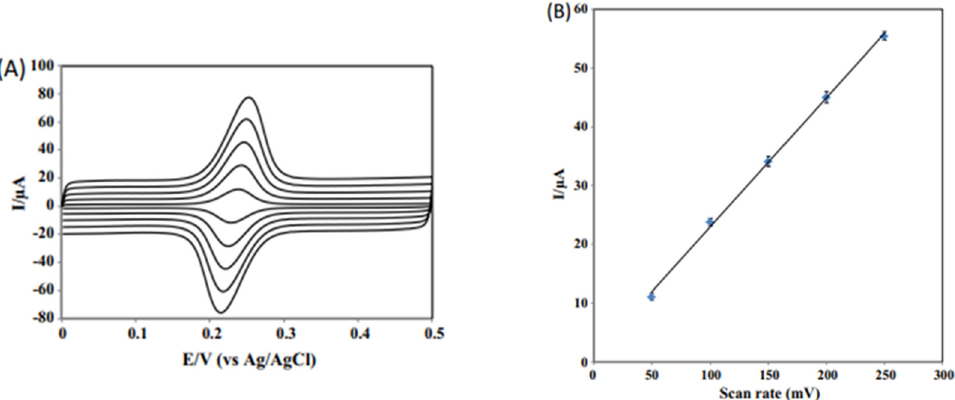
Figure 10. ( A ) CVs of 1.0 × 10 − 7 M CGA at NbNPs/CNTs/GCE in 0.1 M PBS at pH 7.0. Scan rate: 50 mV/s, 100 mV/s, 150 mV/s, 200 mV/s, 250 mV/s (bottom to top). ( B ) A plot of anodic peak currents of CGA versus scan rates. Published from [67] with the permission of the publisher.